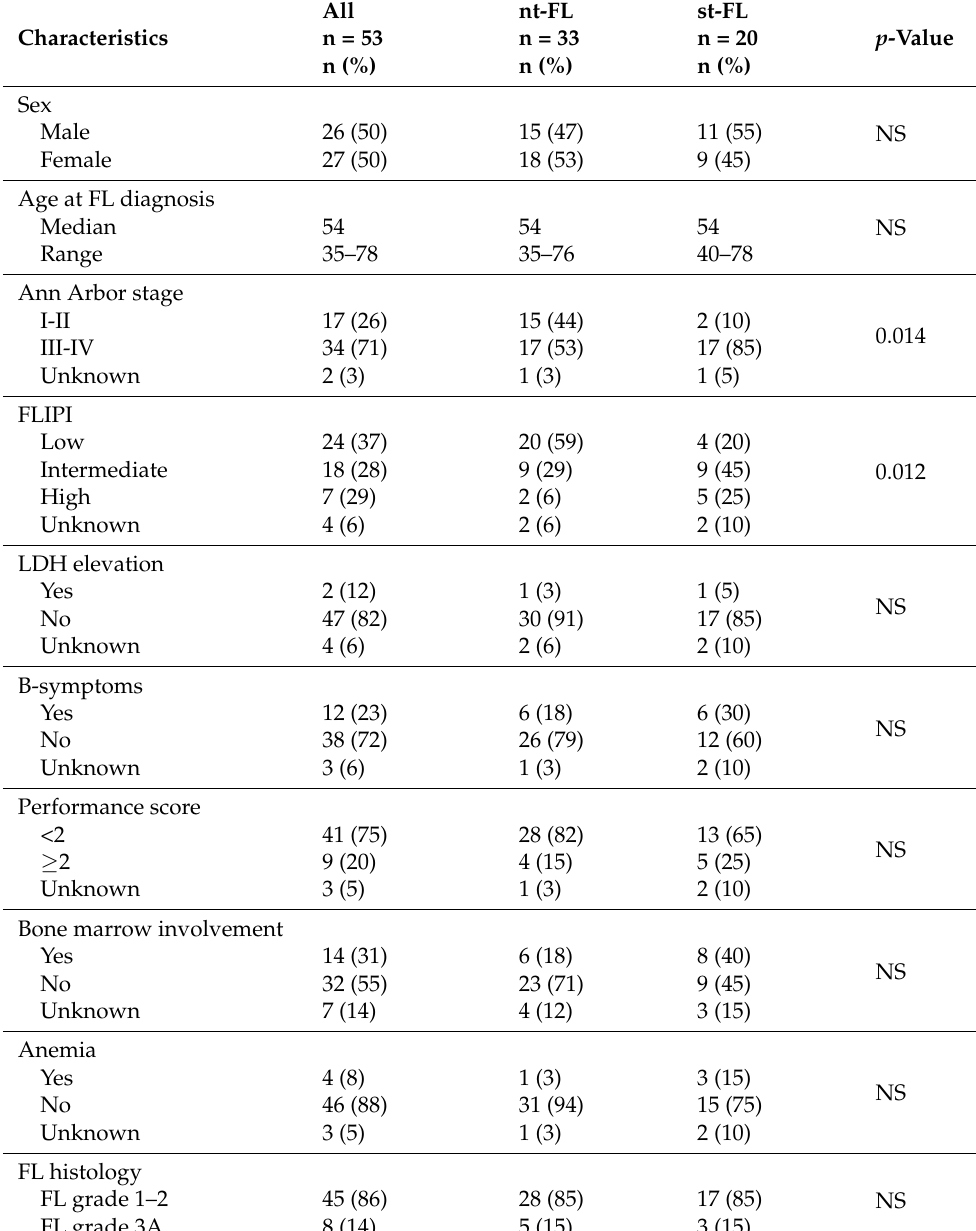
Table 1. Patients’ clinicopathological